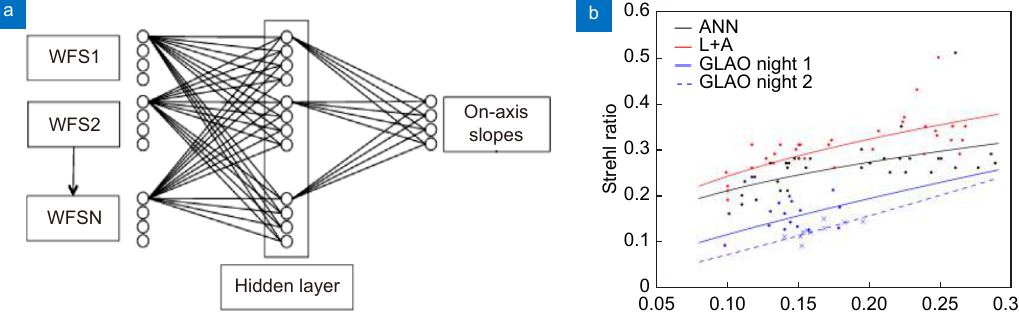
Fig. 13 | ( a ) Network diagram for CARMEN. where the inputs are the slopes of off-axis WFSs and the outputs are the on-axis slopes for the tar- get direction. One hidden layer with the same number of neurons as the inputs is used to link the inputs and outputs and the sigmoid activation function is used. ( b ) On-sky Strehl ratio (in H-band) comparison with different methods. This on-sky experiment was carried out on the 4.2m Willi- am-Herschel Telescope. The Strehl ratios achieved by the ANN (CARMEN), the Learn and Apply (L&A) method and two GLAO night perform- ances are compared. Figure reproduced from (a, b) ref. 84 , Oxford University